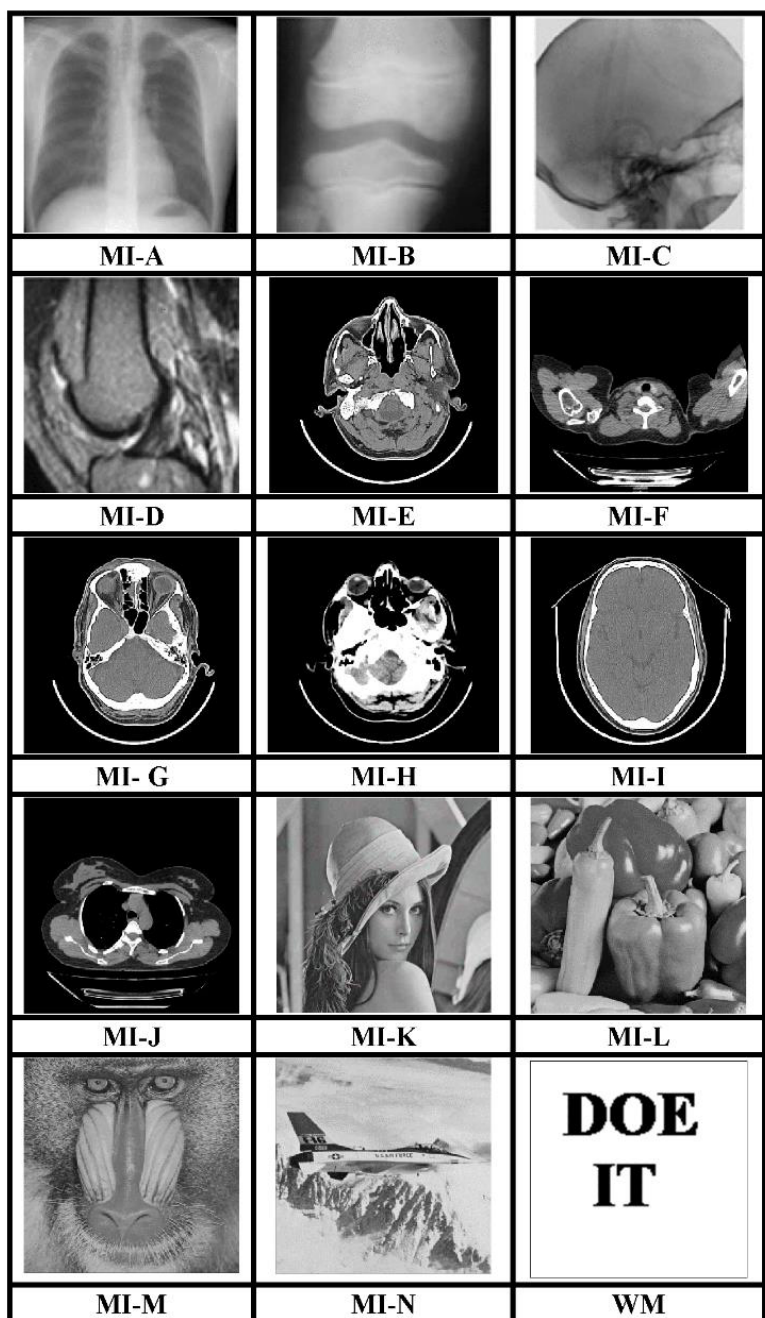
Figure 4. CI Figure 4. CI (Interpolated). Table 1. Quality Objective Metrics.